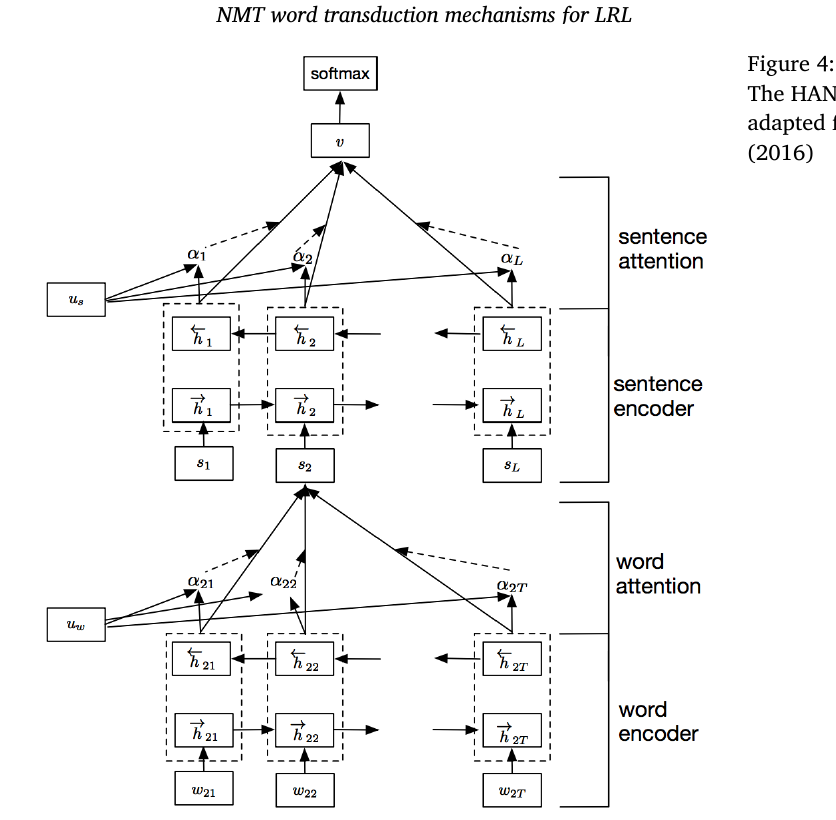
The HAN framework adapted from Yang et